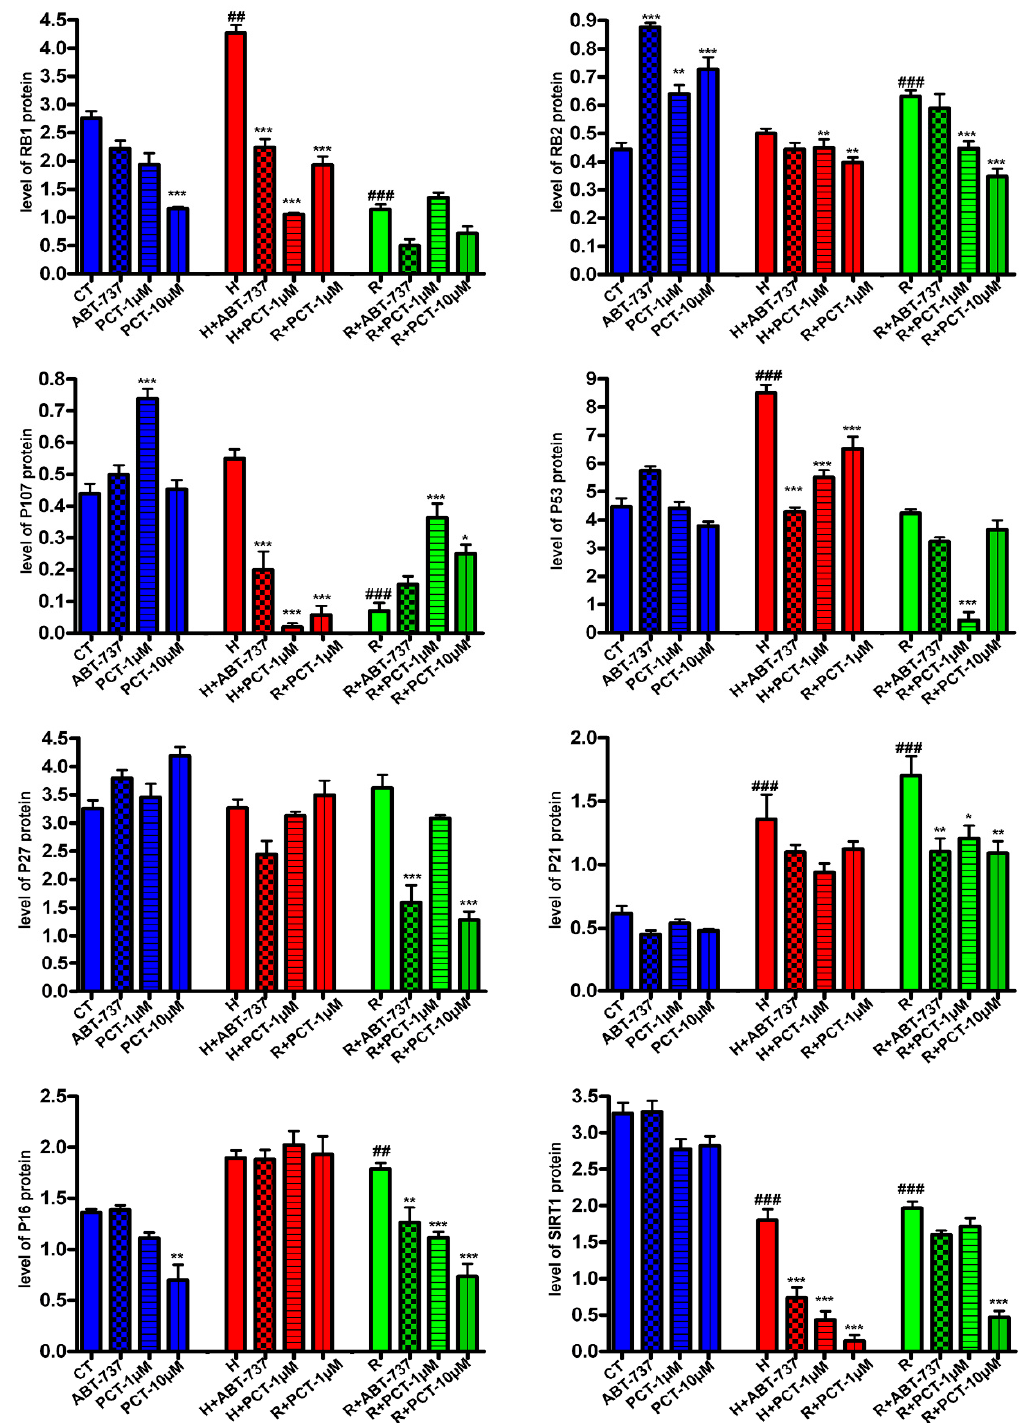
Figure 5. Signaling pathways associated with senescence and the effect of piceatannol treatment. The charts show the expression of RB1/P105, RB2/P130, P107, P53, P27/KIP1, P21/CIP1, P16/INK4A and SIRT1 in control samples (CT) and in samples treated with hydrogen peroxide (H) or in replicative senescence cultures (R). The charts show the densitometric analysis of Western blot bands shown in Supplementary file S3. The expression of proteins of interest was normalized on GAPDH, chosen as the control. The ### p < 0.001 and ## p < 0.01 levels indicate statistical significance between the control and senescent samples. The *** p <0.01 ** p < 0.01 and * p < 0.05 indicate statistical significance between the control samples and samples treated with piceatannol or ABT ‐ 737.